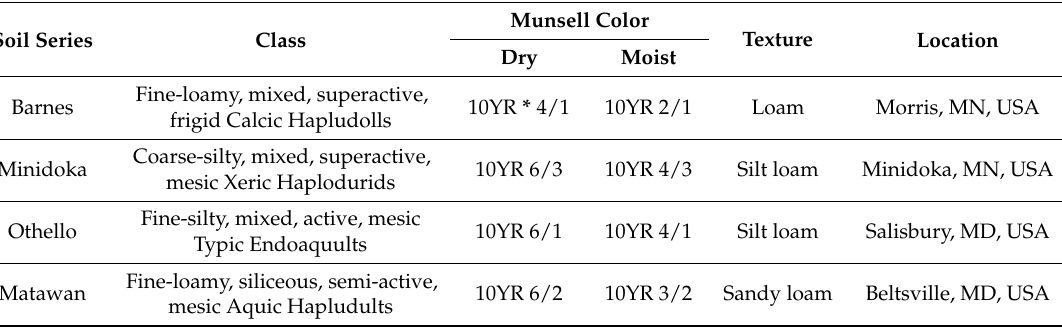
Table 1. Top soils included in this